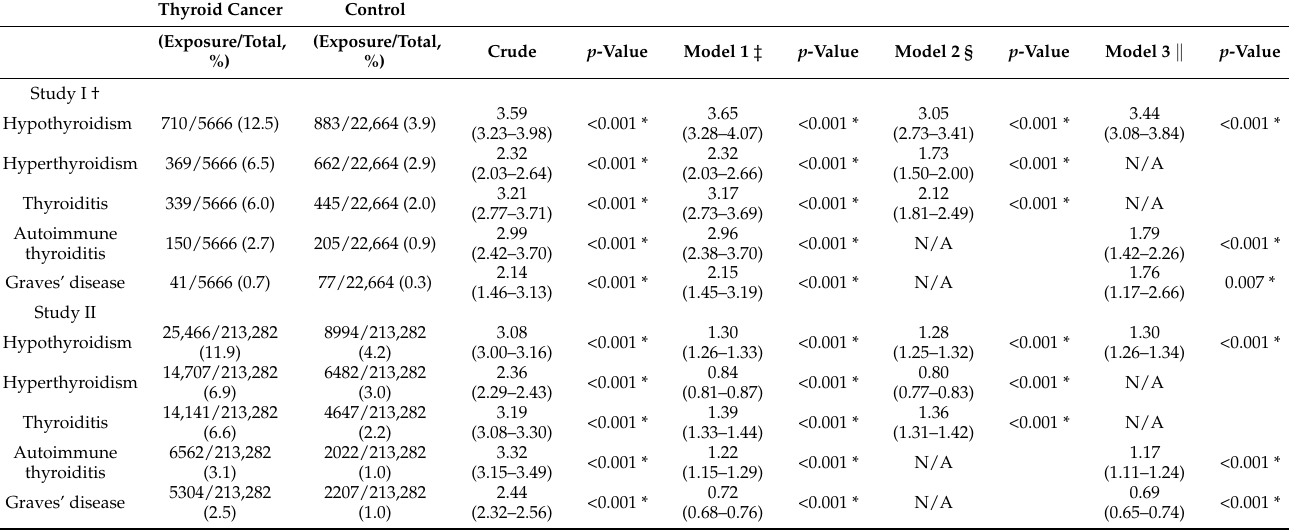
Table 2. Odds ratios (95% confidence interval) for thyroid cancer in hypothyroidism, hyperthyroidism, thyroiditis, autoim- mune thyroiditis, and Graves’